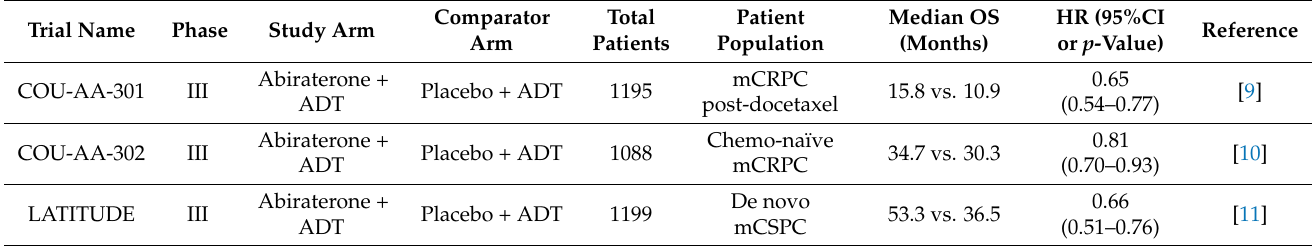
Table 1. Clinical trials that led to U.S. Food and Drug Administration approval of androgen receptor signaling